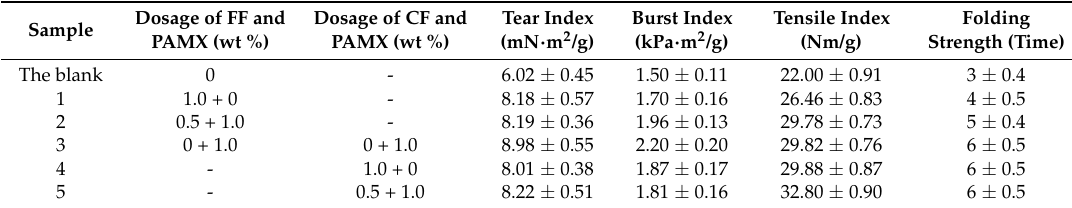
Table 4. Influence of the combination of PAMX and FF or CF on mechanical properties of handsheets of waste paper